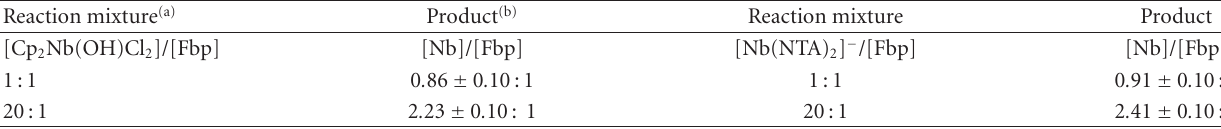
Table 1: Analysis of the products from reactions of apo-Fbp with [Cp 2 Nb(OH)Cl 2 ] and [Nb(NTA) 2 ] − .